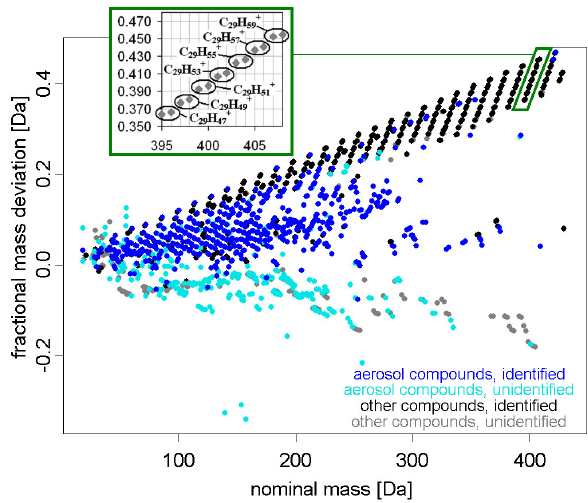
Figure 3. All 1210 mass peaks of the unified-peak-list . The hydrocarbons clearly stand out as straight line in the Figure. The insert enlarges the C 29 hydrocarbons. Note that for these hydrocarbon series typically the two most abundant isotopologues were detected (i.e. the one containing only 12 C atoms, and the species containing one 13 C atom.). To the left and right of the C 29 line are the C 28 and the C 30 lines, respectively. Oxygenated compounds are below the hydrocarbons on the graph because they are typically lighter (m CH4 -m O = 36.4 mDa). Peaks printed in blue or cyan were significantly enhanced in aerosols. Peaks printed in blue and black were identified by their empirical formula; peaks printed in cyan and grey were only identified by their molecular weight. Note that most high molecular weight hydrocarbon signals were not detected in aerosols but due to instrumental background.